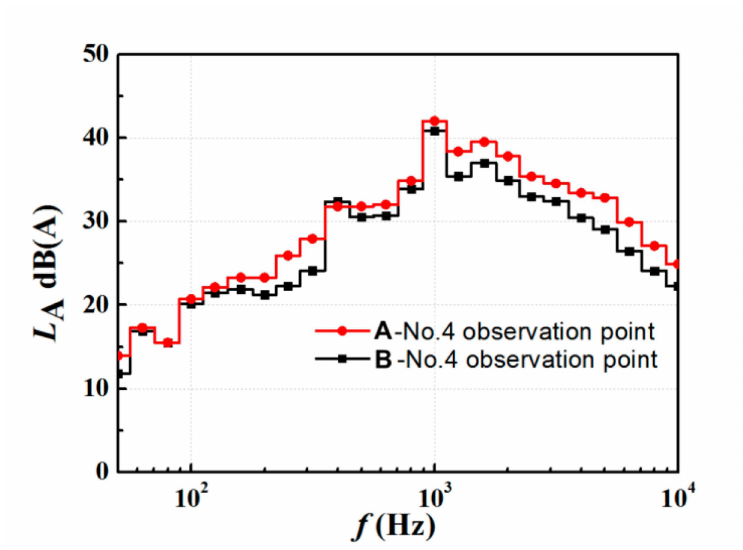
Figure 14. Comparison of 1/3 frequency-range noise of measuring point 4 in different blade models at 1000 rpm and 0.204 m 3